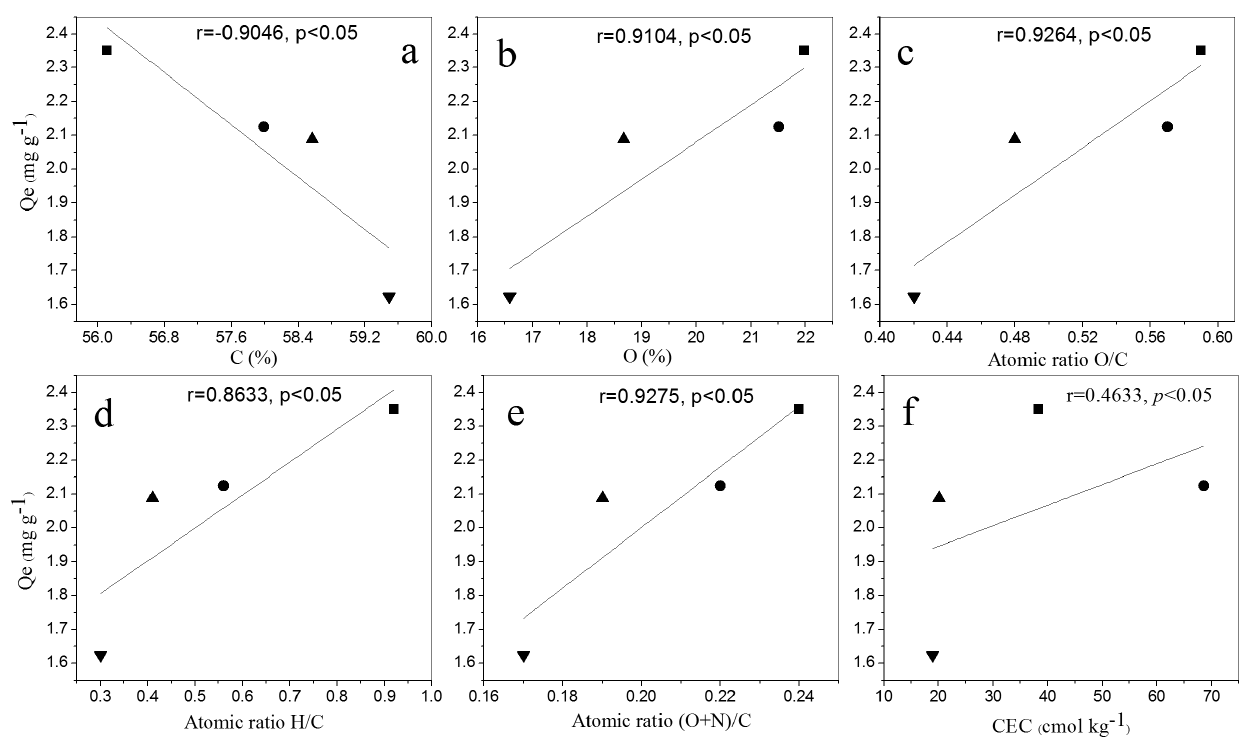
Figure 3. Correlations between mass of NH 4 + -N adsorbed per mass of biochar at equilibrium (Qe) and content of C (a), content of O (b), atomic ratio O/C (c), atomic ratio H/C (d), atomic ratio (O + N)/C (e) and CEC of corn-straw biochar (f), respectively. The symbols & , $ , m and . represented pyrolysis temperatures at 400 ˚ C, 500 ˚ C, 600 ˚ C and 700 ˚ C,